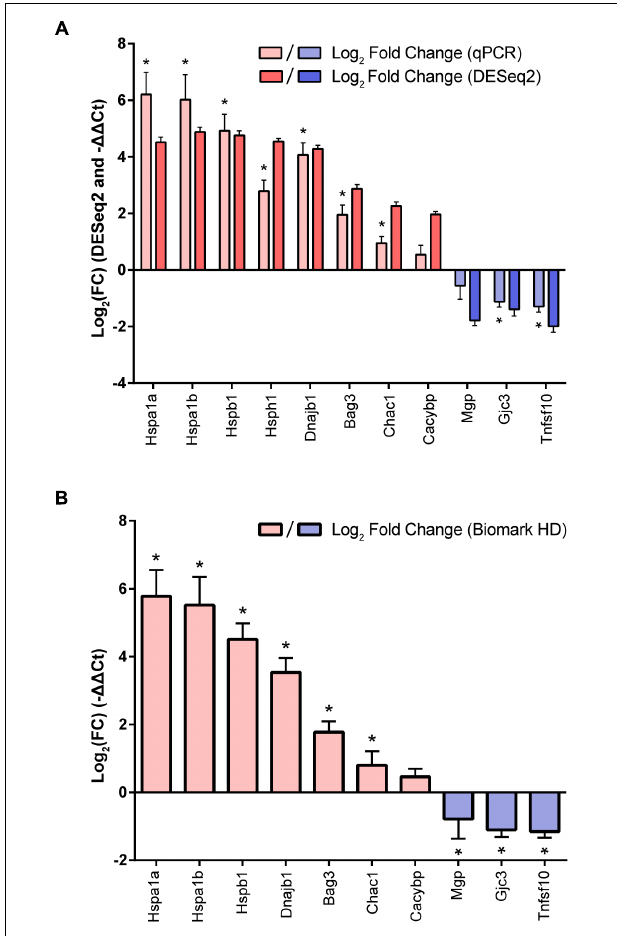
FIGURE 2 | Validation of the utricle heat shock transcriptional signature. (A) Fold changes (mean ± standard error values calculated from the DESeq2 model) of eight enriched and three depleted DEGs from the heat shock transcriptional signature are shown in dark red and dark blue, respectively. RT-qPCR fold changes (normalized to Actb) performed in independent replicates ( n = 3 biological replicates per group) for the same eight enriched and three depleted DEGs are shown in light red and light blue, respectively. (B) Fold changes from independent replicates for seven enriched and three depleted DEGs from the heat shock signature normalized to Gapdh and measured on the Biomark HD system show similar induction patterns as measured in (A) . Asterisks indicate statistically significant ( p < 0.05) differences in heat shock (cid:49) Ct values compared to control replicates as measured by multiple unpaired t-tests following Holm-Sidak multiple comparison correction, represented above each (cid:49)(cid:49) Ct value.